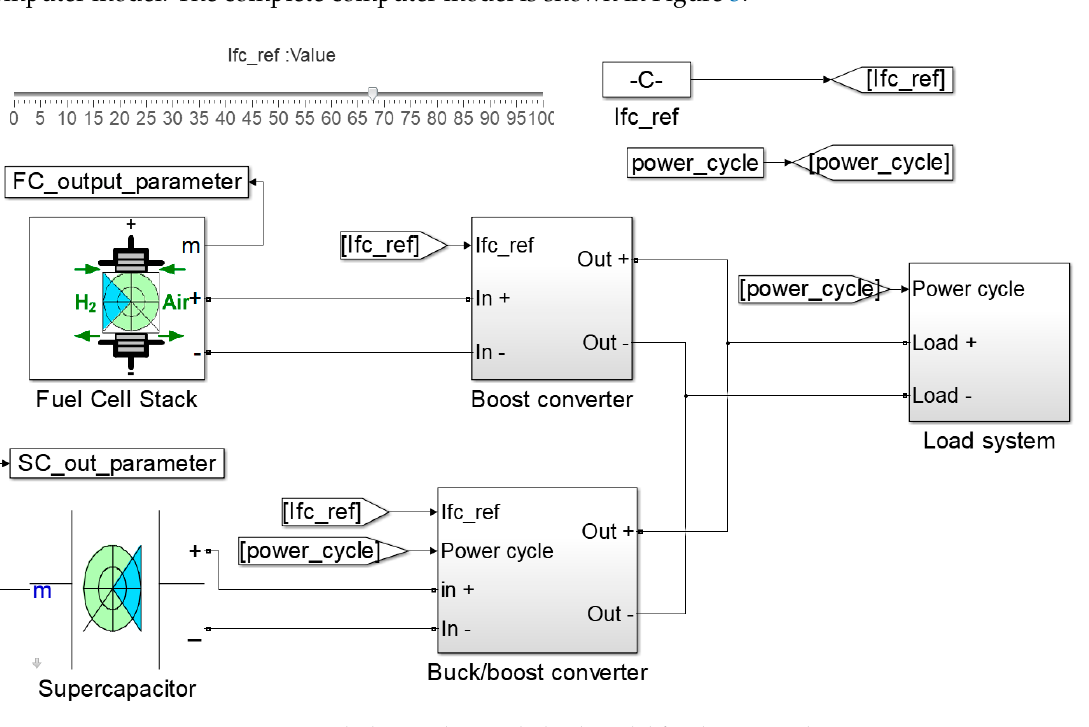
Figure 3. Simulink complete FC hybrid model for driving cycle test.